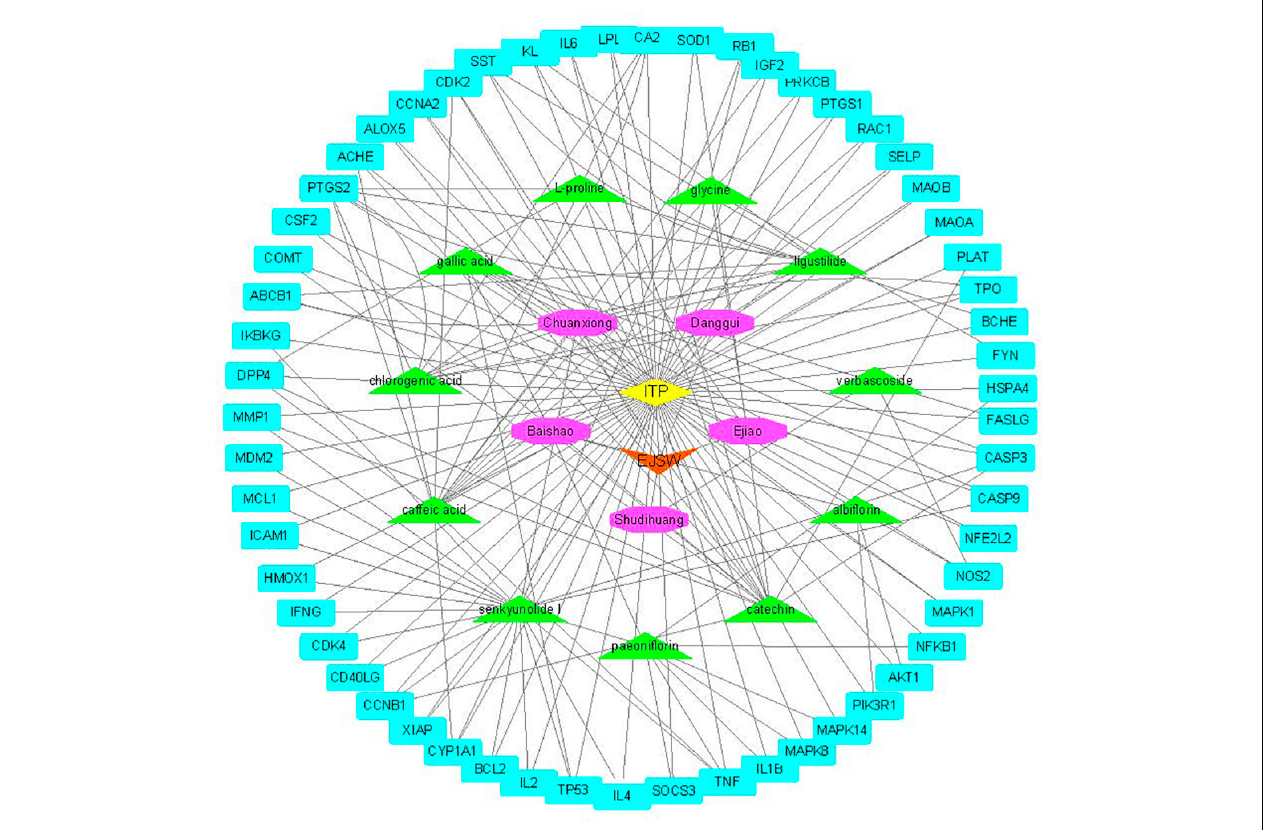
FIGURE 4 | Disease-compound-target network of EJSW against. The blue rectangles represent targets. The green triangles represent the compounds. The purple octagons represents the five herbs of EJSW. The orange triangle represents EJSW and the yellow diamond represents ITP.